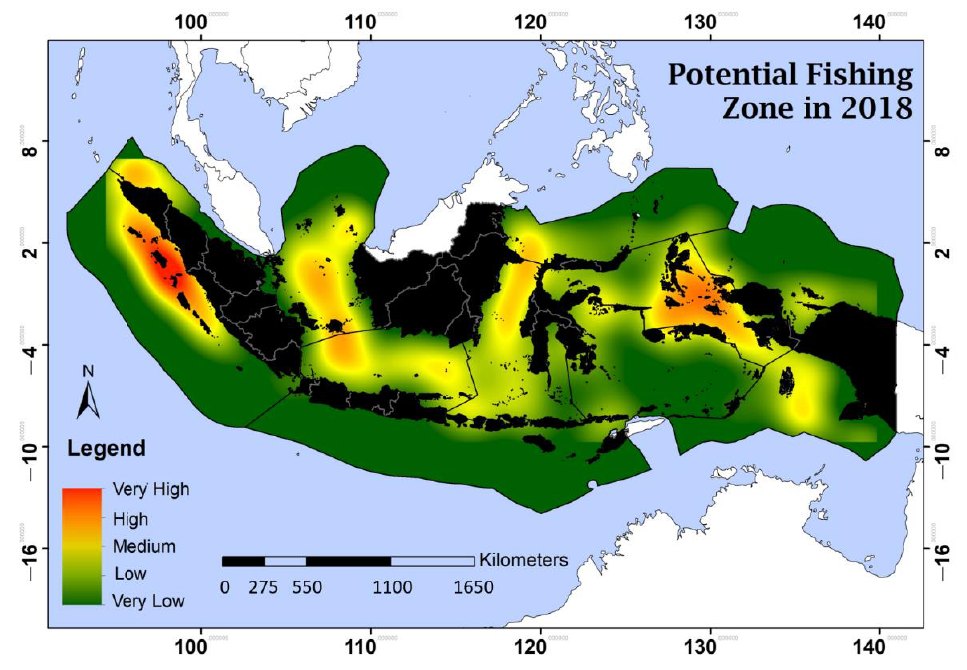
Figure 7. Average potential fishing zones in 2018. Regions with a high monthly average potential dominance during 2018 were WPP- RI 572 and WPP-RI 715. Moreover, WPP-RI 711, WPP-RI 712, and WPP-RI 718 showed medium potential. VAZ in Indonesia in 2018 was divided into three classes: low, medium, and high, and the location of each class varied monthly, particularly in WPP-RI 571, WPP- RI 712, and WPP-RI 718 (Figure 8). WPP-RI 571, with high VAZ, was observed in Febru-